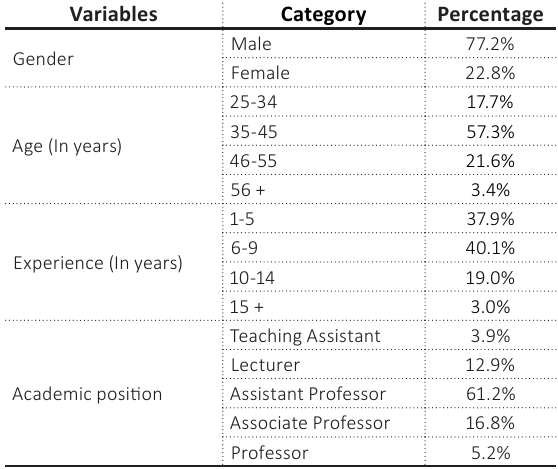
Table 1. Profile of